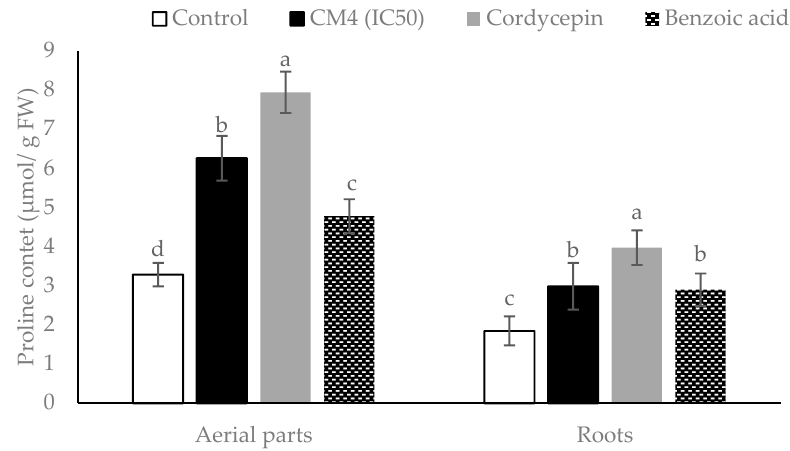
Figure 7. Proline contents in root and aerial parts of radish treated by CM4 fraction, synthetic cordycepin and BA at 0.04 mg/mL. Columns with different superscript letters ( a,b,c,d ) were significantly different at p < 0.05 by Fisher’s test.